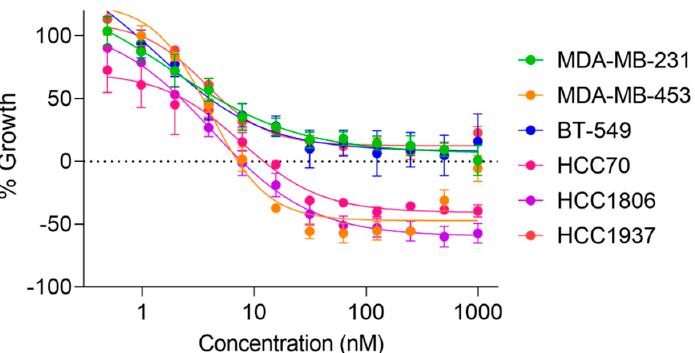
Figure 2. Concentration-dependent antiproliferative and cytotoxic effects of zampanolide in a panel of TNBC cell lines. The cell density at the time of drug addition is represented by the dashed line at y = 0 such that cytotoxicity is represented by values that drop below this line. Analysis with non-linear regression log(agonist) vs. response–variable slope. N = 3 ± SEM.